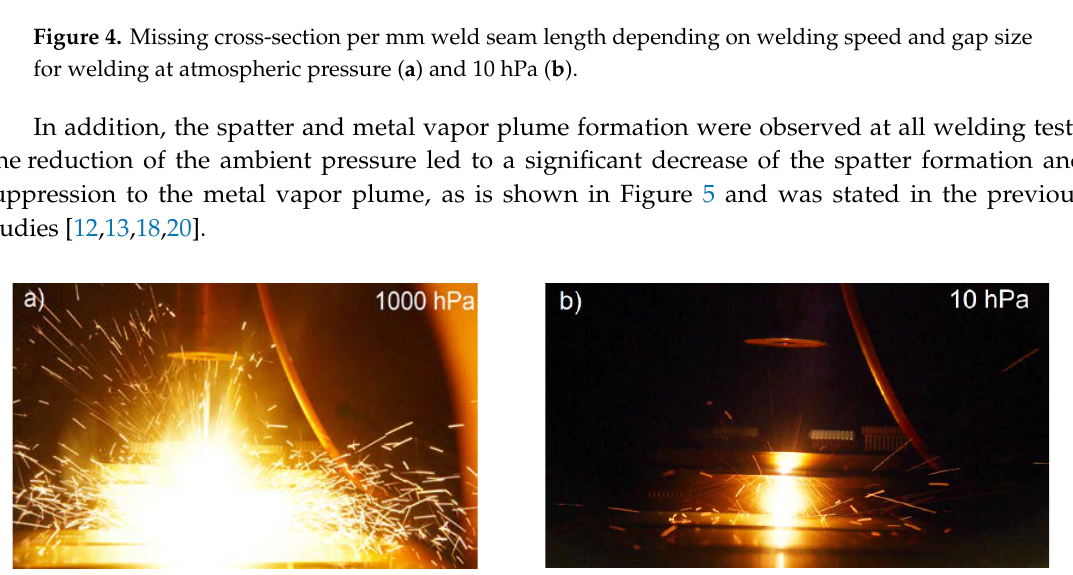
Figure 5. Spatter and metal vapor plume in the case of 0.2 mm gap, performed with 5 m/min welding speed and different ambient pressure (( a ): 1000 hPa and ( b ): 10 hPa).